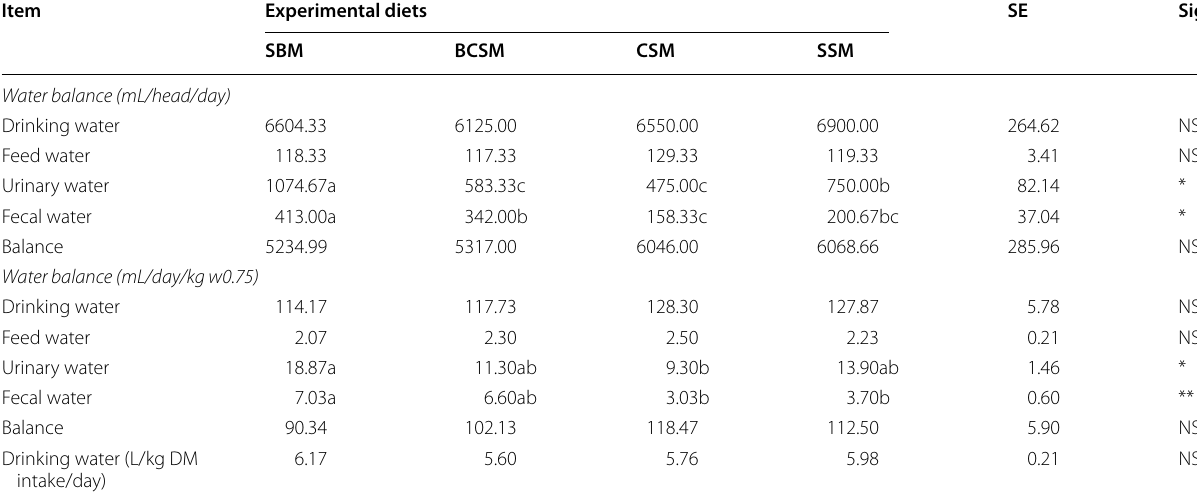
Table 7 Water balance of Farafra sheep fed different experimental diets